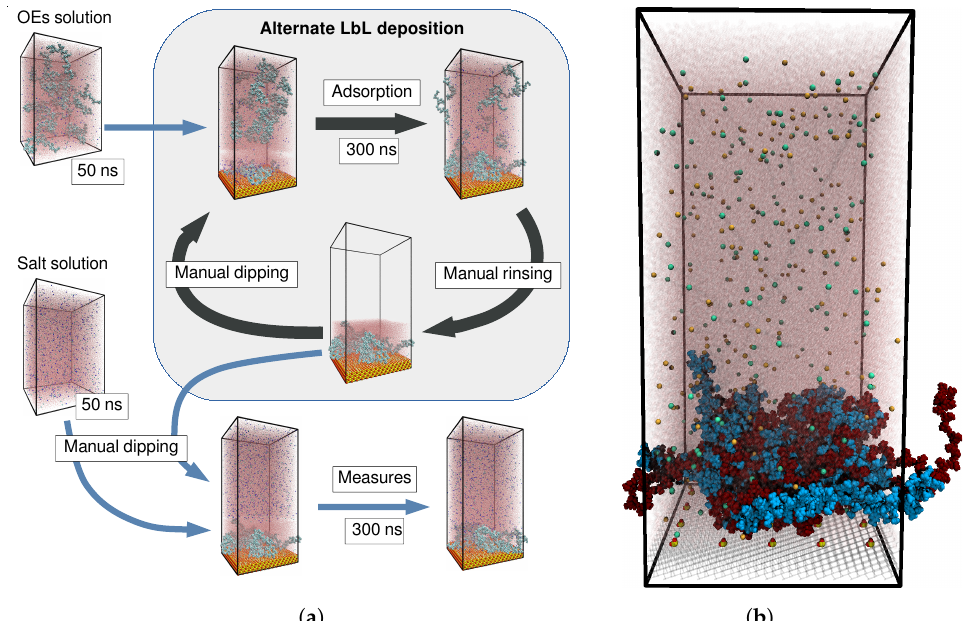
Figure 1. ( a ) Scheme of the simulation protocol used to reproduce the main steps of the LbL growth process. ( b ) Simulation snapshot of an OEM system obtained after four deposition cycles and exposure to a solution of 0.1 M of NaCl. PDADMAC oligomers are colored in dark red, PSS ones in light blue. Na + and Cl − ions are colored in pale orange and blue, respectively. The silica substrate is represented as a wireframe, except for its surface charged groups. Water molecules are translucent to ease the